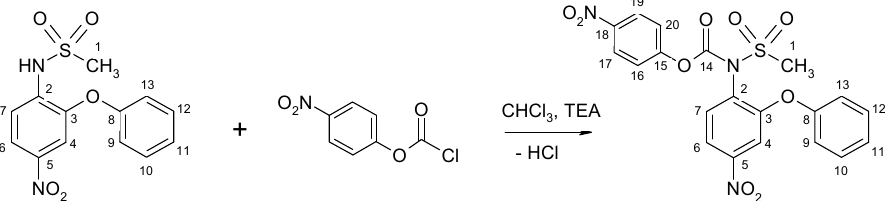
total of 64 2,3-dihydroxypropyl substituents with 128 free hydroxyl groups.